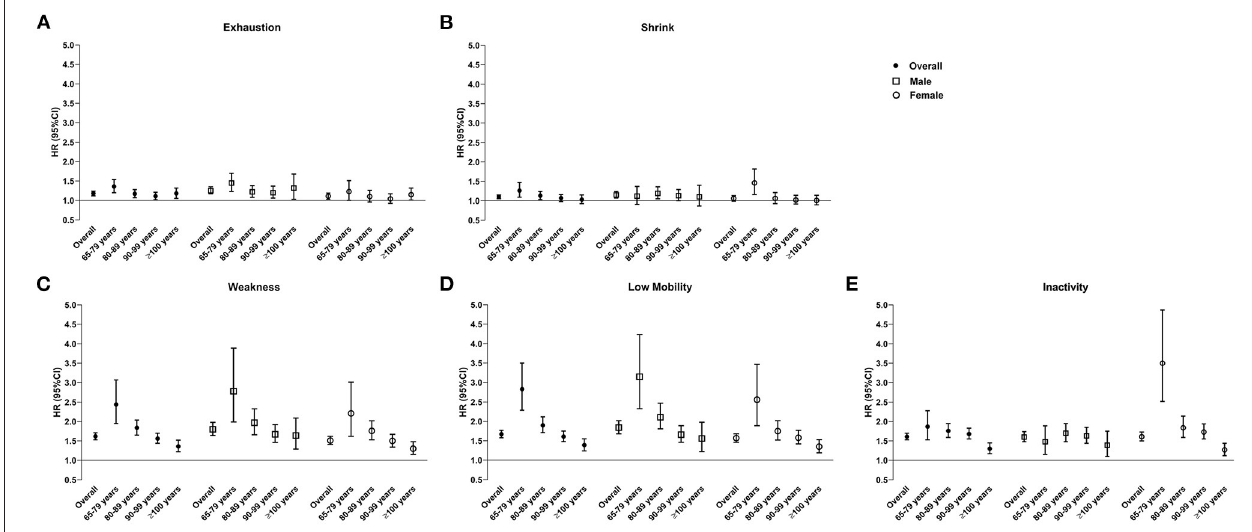
FIGURE 3 | Association between domains of frailty [ (A) exhaustion, (B) shrink, (C) weakness, (D) low mobility, and (E) inactivity] and the risk of all-cause mortality, age-, and gender-stratified. Adjusted for: education, household income, smoke status, and comorbidity count at